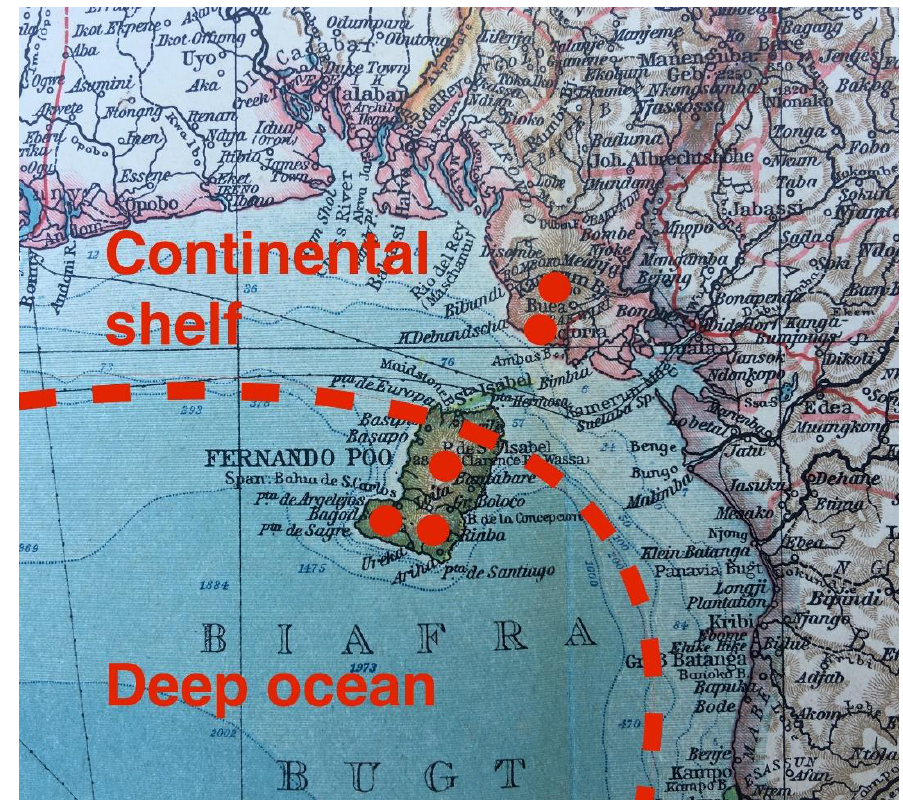
Figure 3 . Map of Bioko (Fernando Póo) and the margin of the African continental shelf. The northeastern point of the island is 32 kilometers from mainland Africa. Bathymetric contours are 20, 50, 100, 200, 1000, and 2000 meters. The red dashed line marks the probable 200 meter contour early in the history of proto-Bioko. Red spots show recent volcanic centers. Map from Andree